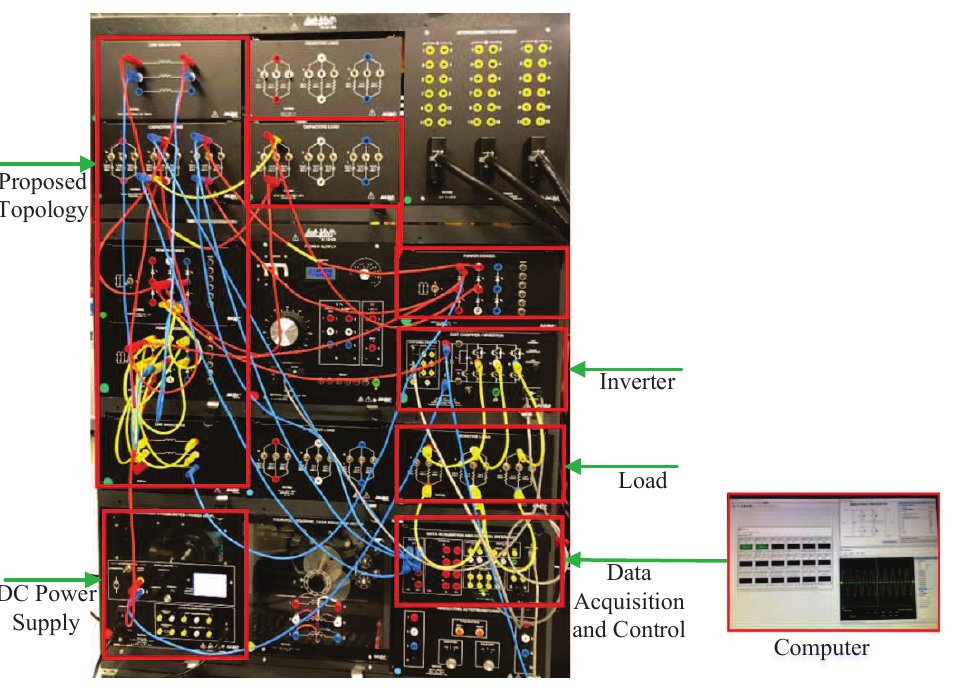
Figure 15. Experimental